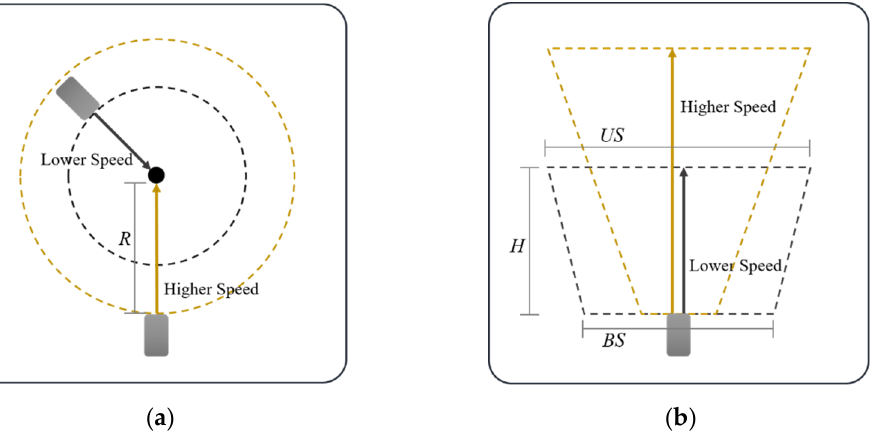
Figure 4. ( a ) Circular grid map of previous paper [1]. ( b ) Proposed trapezoidal grid map. R is the radius of the circle. US is the upper side of the trapezoid. BS is the base of the trapezoid. H is the height of the trapezoid.